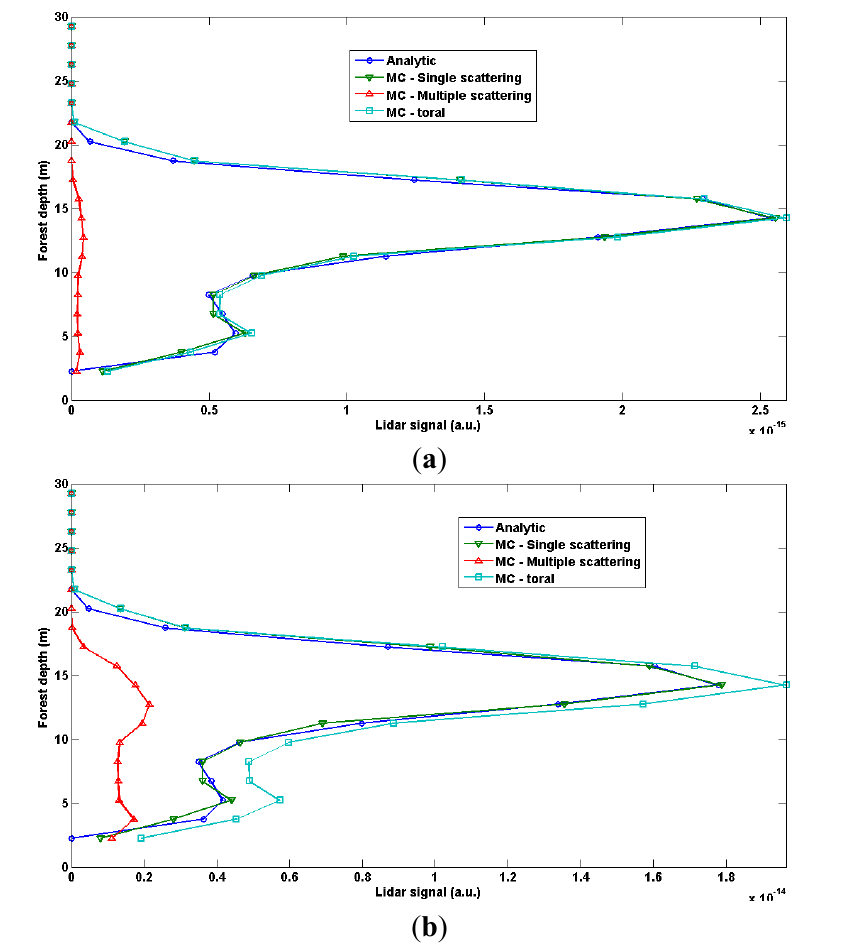
Figure 12. Multiple scattering effect simulations at ( a ) 355 nm and ( b ) 1064 nm for oaks in summer by using a similar orbit of ISS at 350